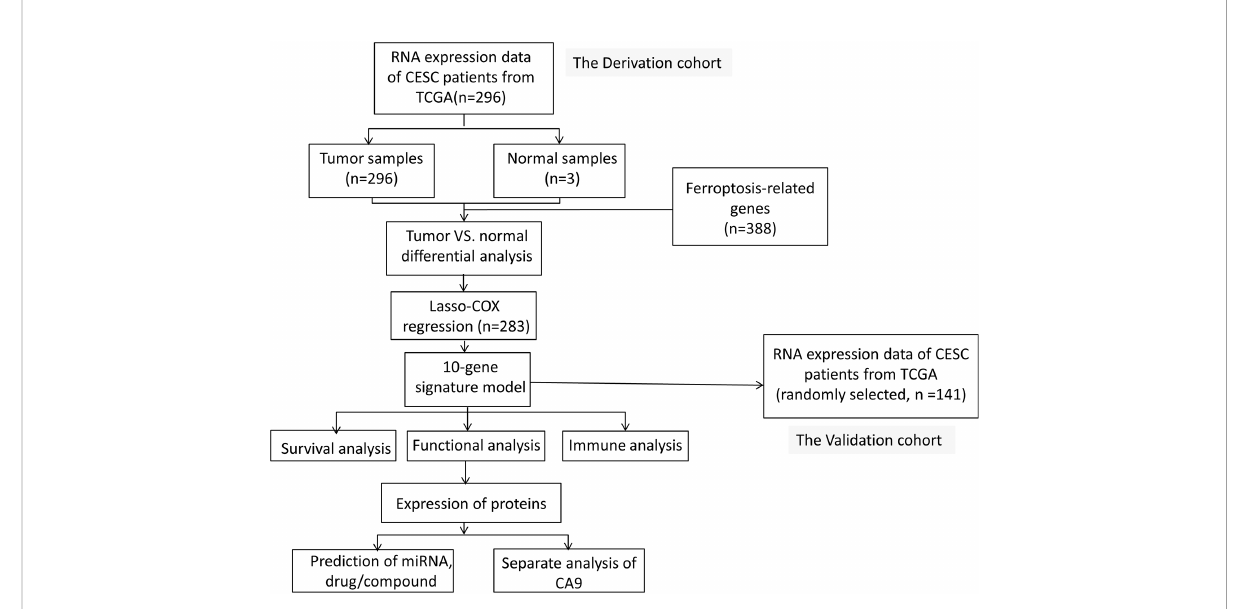
FIGURE 1A Flowchart depicting the construction and validation of data collection and